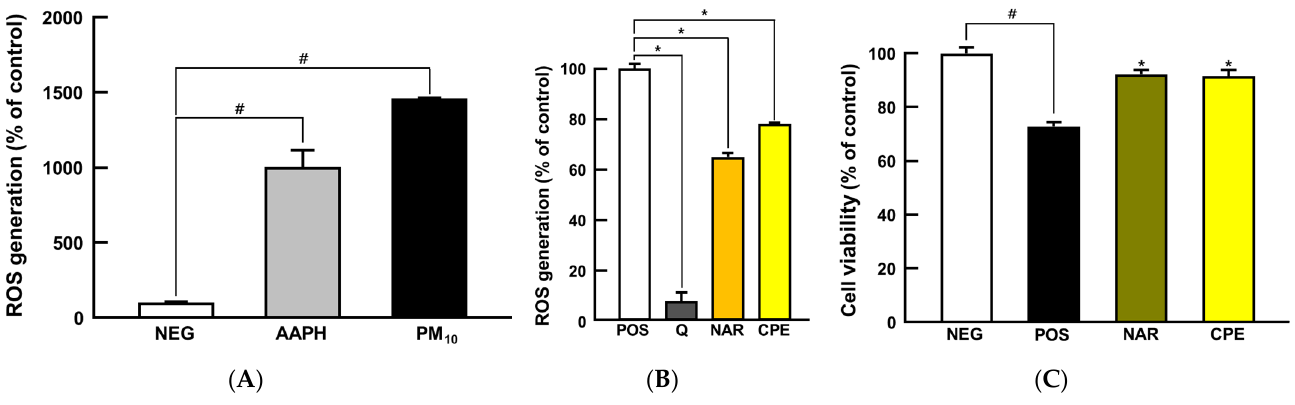
Figure 2. Protective effects of CPE and NAR against PM 10 -induced oxidative stress in NCI-H460 cell line. ( A ) ROS generation, ( B ) intracellular antioxidant activity, and ( C ) cell viability. All values are expressed as mean ± SEM. p- value less than 0.05 was considered statistically significant. # indicates statistical significance compared to the NEG group, and * indicates statistical significance compared to the POS group. AAPH, 2,2 ′ -azobis(2-methylpropionamidine) dihydrochloride; CPE, Citrus junos Tanaka peel extract; NAR, naringin; PM 10 , particulate matter 10; Q, quercetin; ROS, reactive oxygen species.